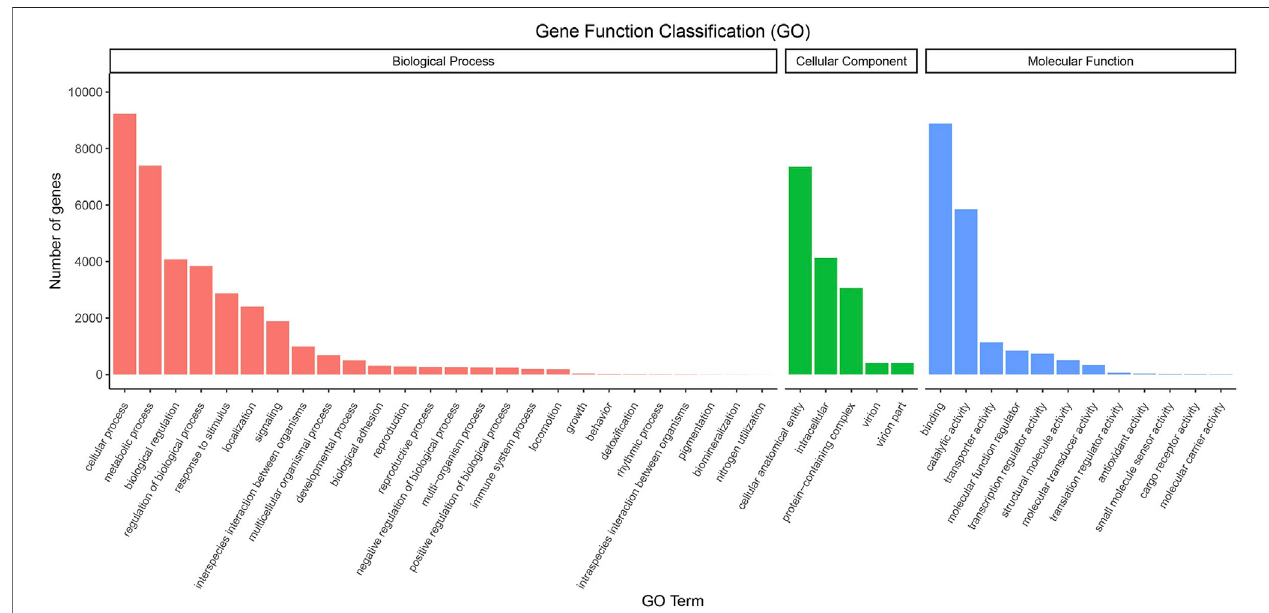
FIGURE1| GOclassi fi cationsoftheunigenesequences.Annotateduniquesequenceswereclassi fi edintoBiologicalProcess,CellularComponent,andMolecular Function.